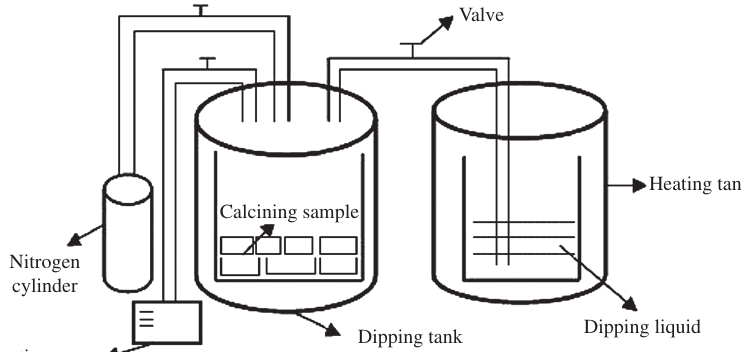
Figure 2 Impregnating device schematic diagram.